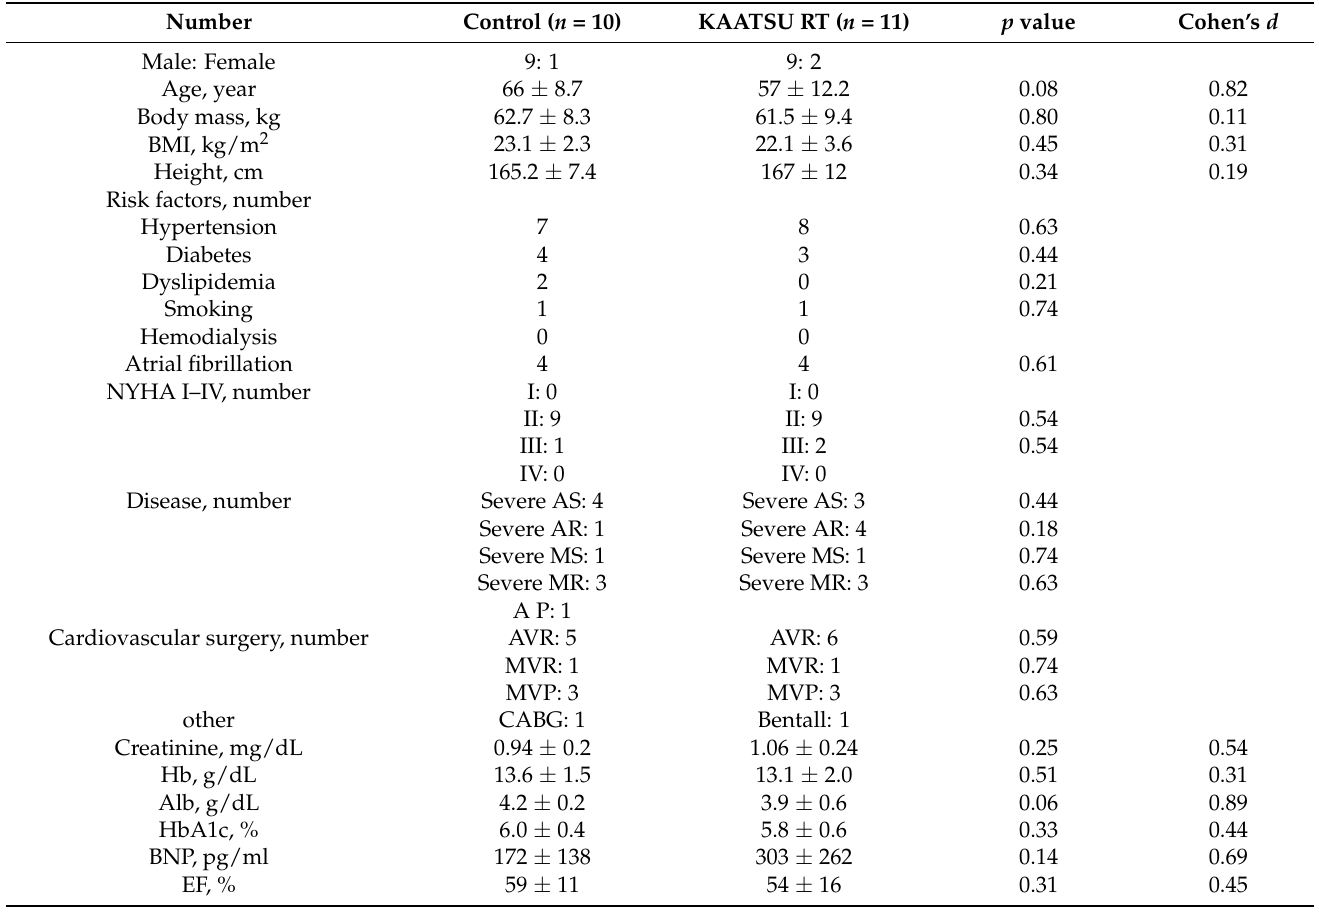
Table 2. The baseline patients’